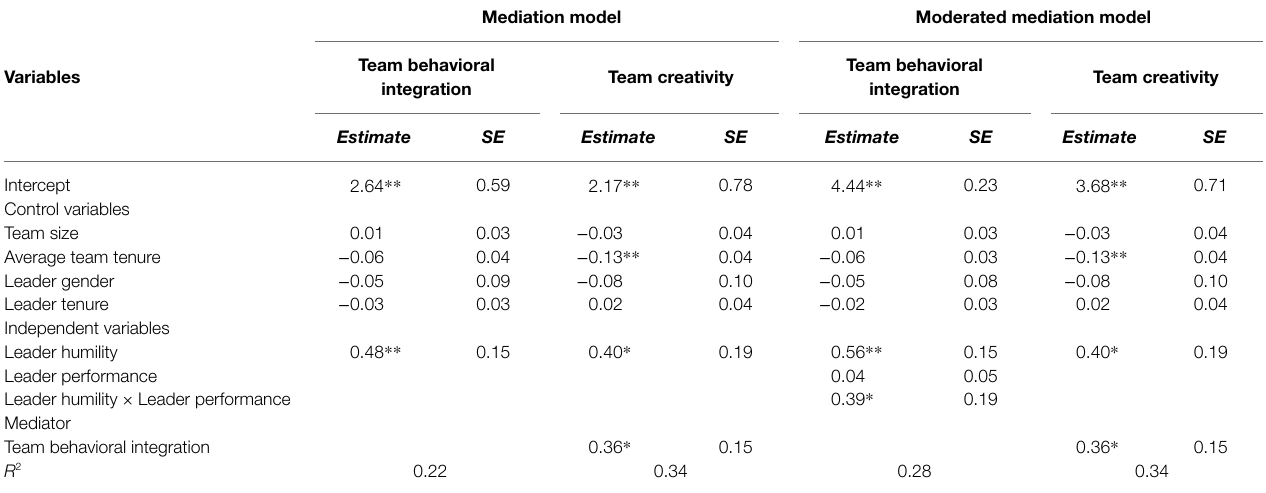
TABLE 2 | Unstandardized path modeling results.